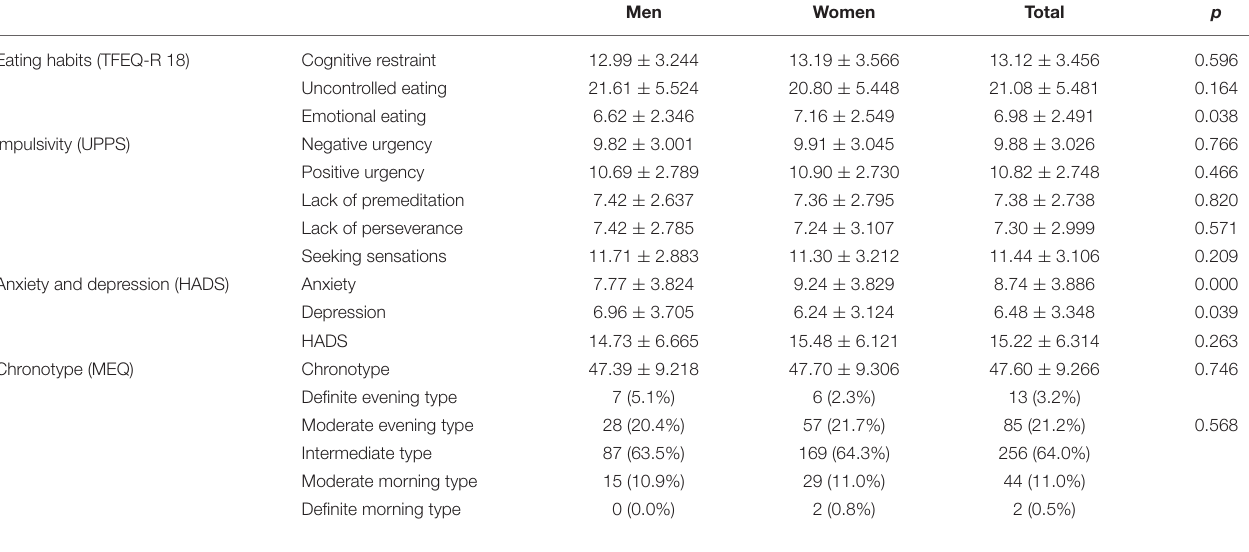
TABLE 2 | Eating habits, impulsivity, chronotype, anxiety, and depression: average scores, standard deviation (SD) and percentages.